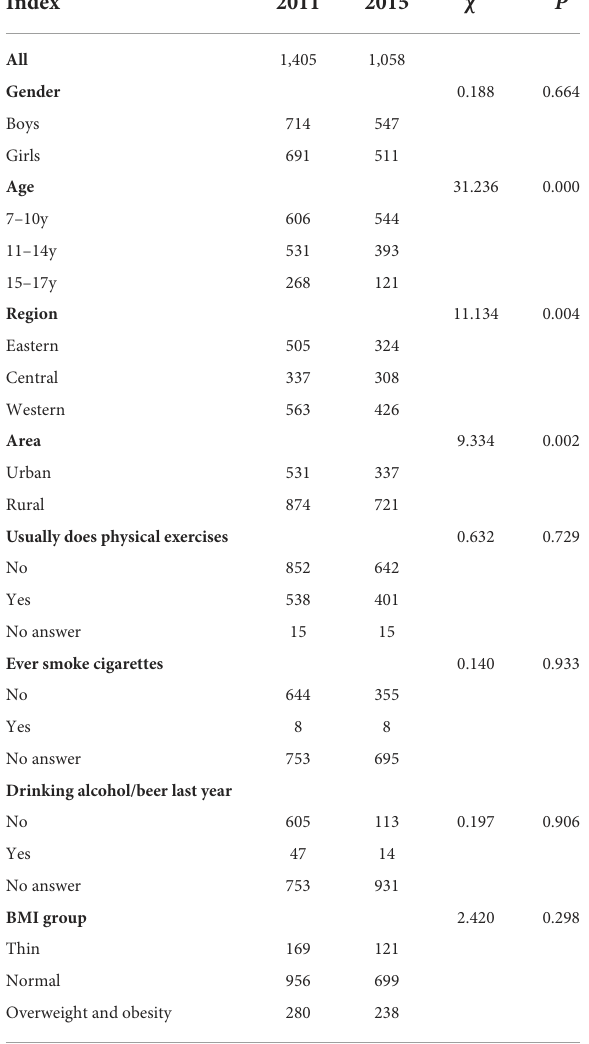
TABLE 1 The demographics of surveyed children,